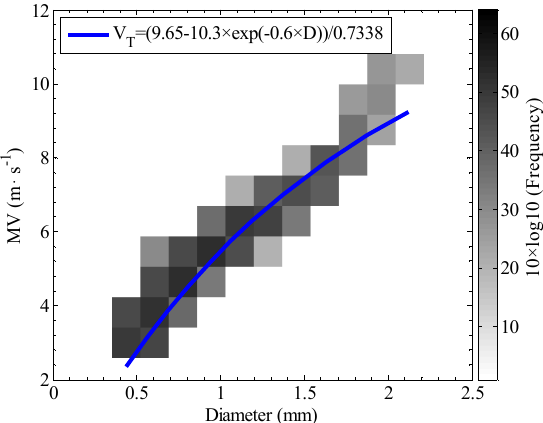
Figure 10. Frequency distribution of diameter (D) and MV of the observed raindrops collected from 15 July to 30 August 2015 under weak precipitating conditions. The blue solid line represents a fitting equation for the V T − D relationship.